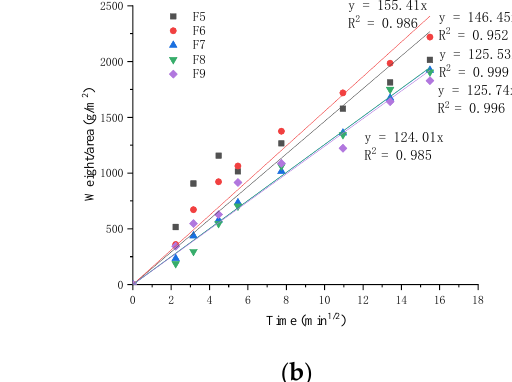
Figure 8. Capillary water absorption of NS-modified mortar: ( a ) 50% FA and ( b ) 60% FA.